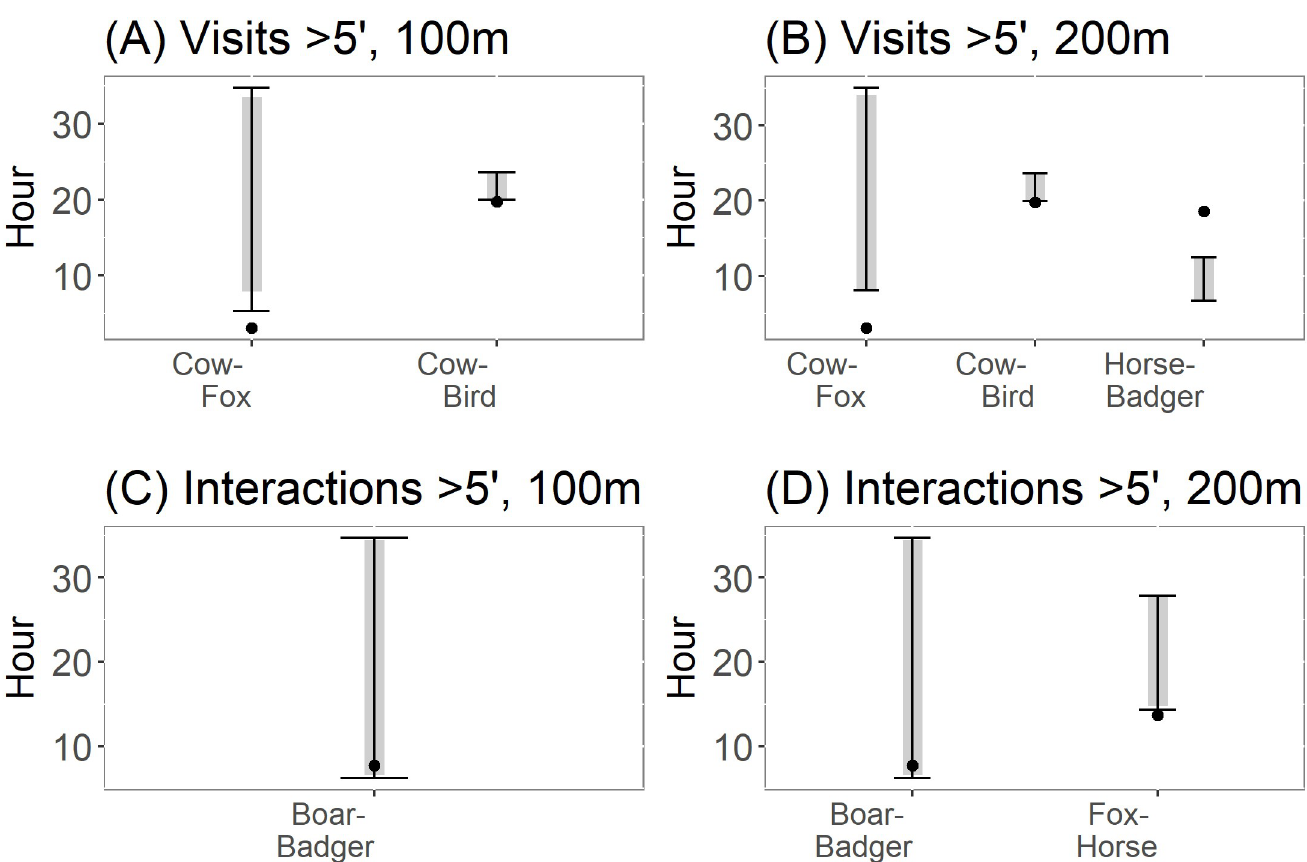
Fig 3. Significant interactions between frugivores of Chamaerops humilis resulting from applying null model 2. Black dots indicate the observed mean time differences (OMTD). Black lines and grey bars represent the expected 95% and 90% intervals of time elapsed between visits, respectively. (A) Interactions derived from the whole set of visit data, using C . humilis individuals at a minimum distance of 100 m. (B) Interactions derived from the whole set of visit data, using C . humilis individuals at a minimum distance of 200 m. (C) Interactions derived from data corresponding to frugivores physical interactions with C . humilis at a minimum distance of 100 meters. (D) Interactions derived from data corresponding to frugivores physical interactions with C . humilis at a minimum distance of 200